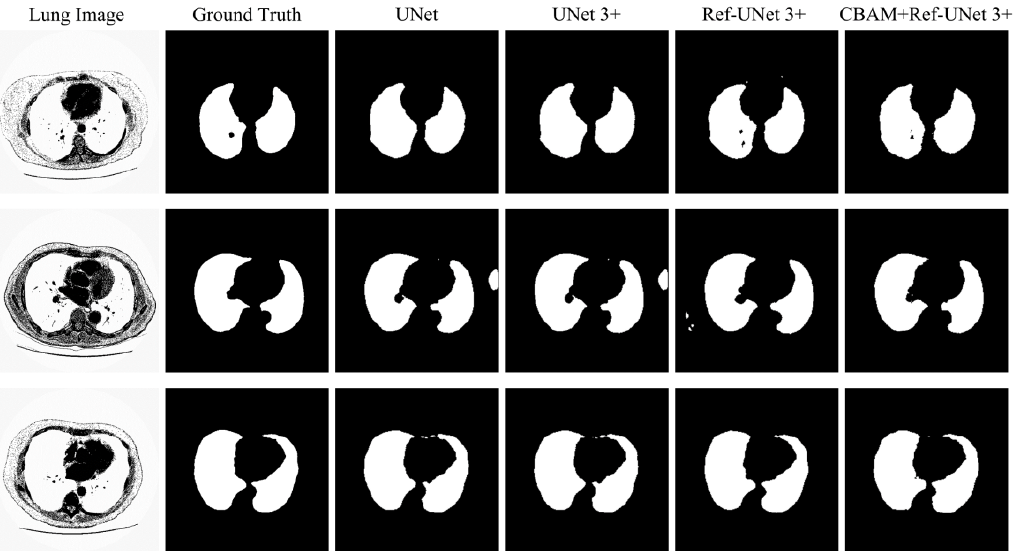
Figure 12. Visualization of lung segmentation results. From left to right: original image, ground truth, segmentation result of Unet, segmentation result of Unet 3+, segmentation result of Ref-Unet 3+, and segmentation result of CBAM+Ref-Unet 3+.